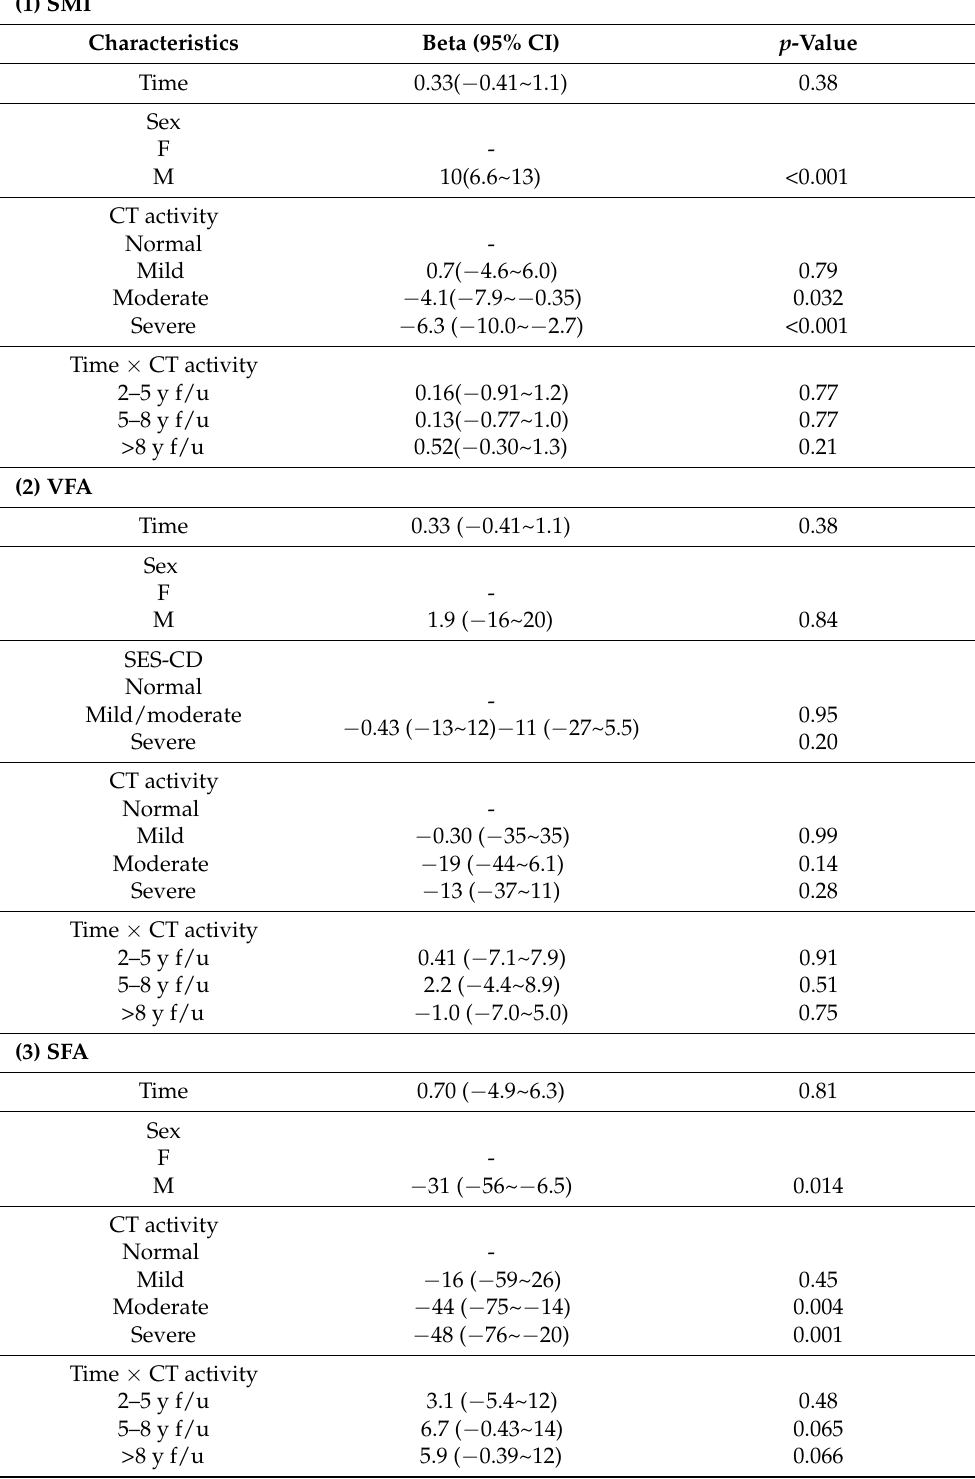
Table 3. Association of body composition with CT activity scores or SES-CD